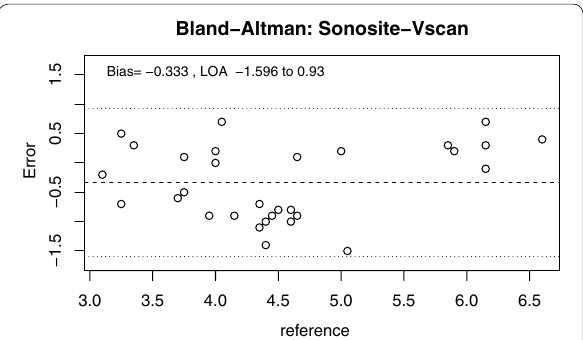
Fig. 2 Bland–Altman plot demonstrating the variability of SonoSite ( black ) and Vscan ( red ) measurements over the range of ONSD sizes Fig. 3 Bland–Altman plot demonstrating the variability of SonoSite– Vscan measurements over the range of ONSD